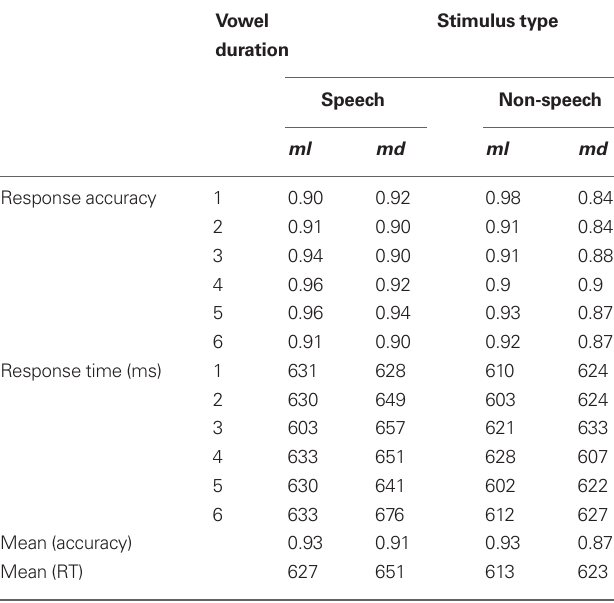
Table 2 | Mean response accuracy and response time to speech and non-speech stimuli in experiment